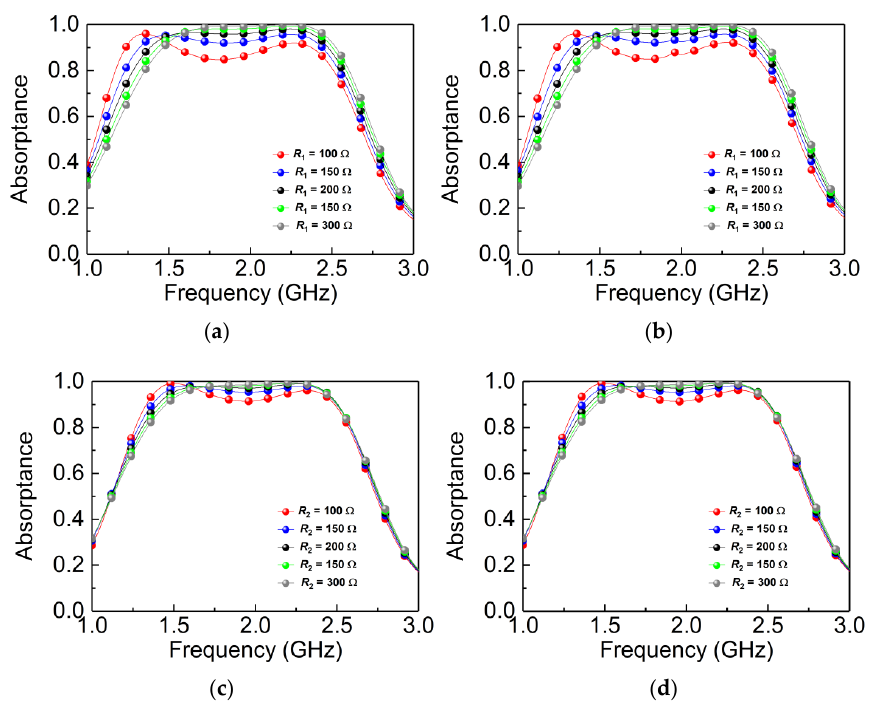
Figure 6. Simulated absorptance with different values of R 1 , R 2 : ( a , c ) TE wave; ( b , d ) TM wave.